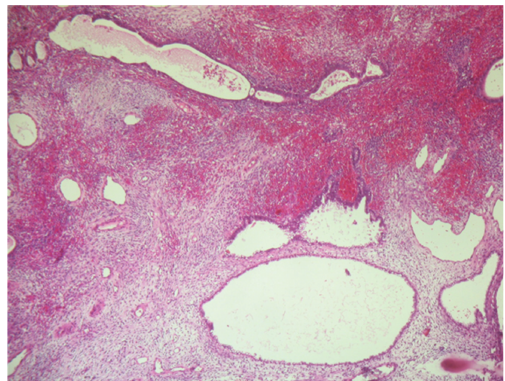
Figure 4: adenosarcoma with phyllodes-like appearance and dense periglandular stromal